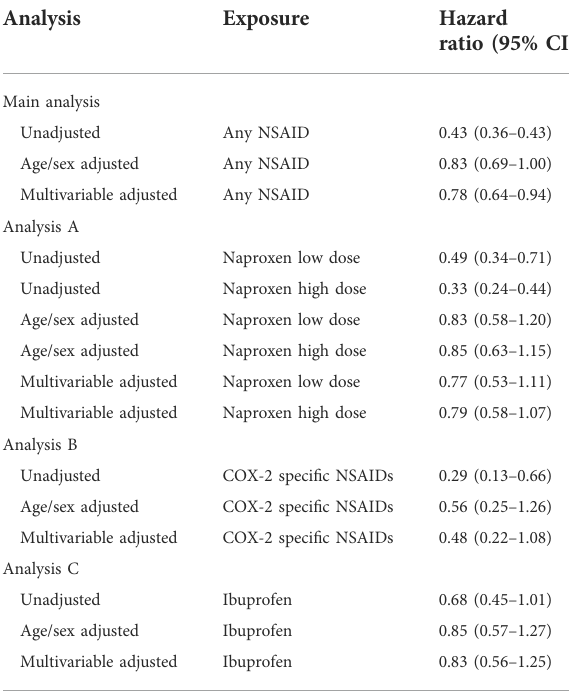
TABLE 3 Hazard ratios of the association between current use of NSAIDs and COVID-19 deaths in the general population (Wong et al., 2021).